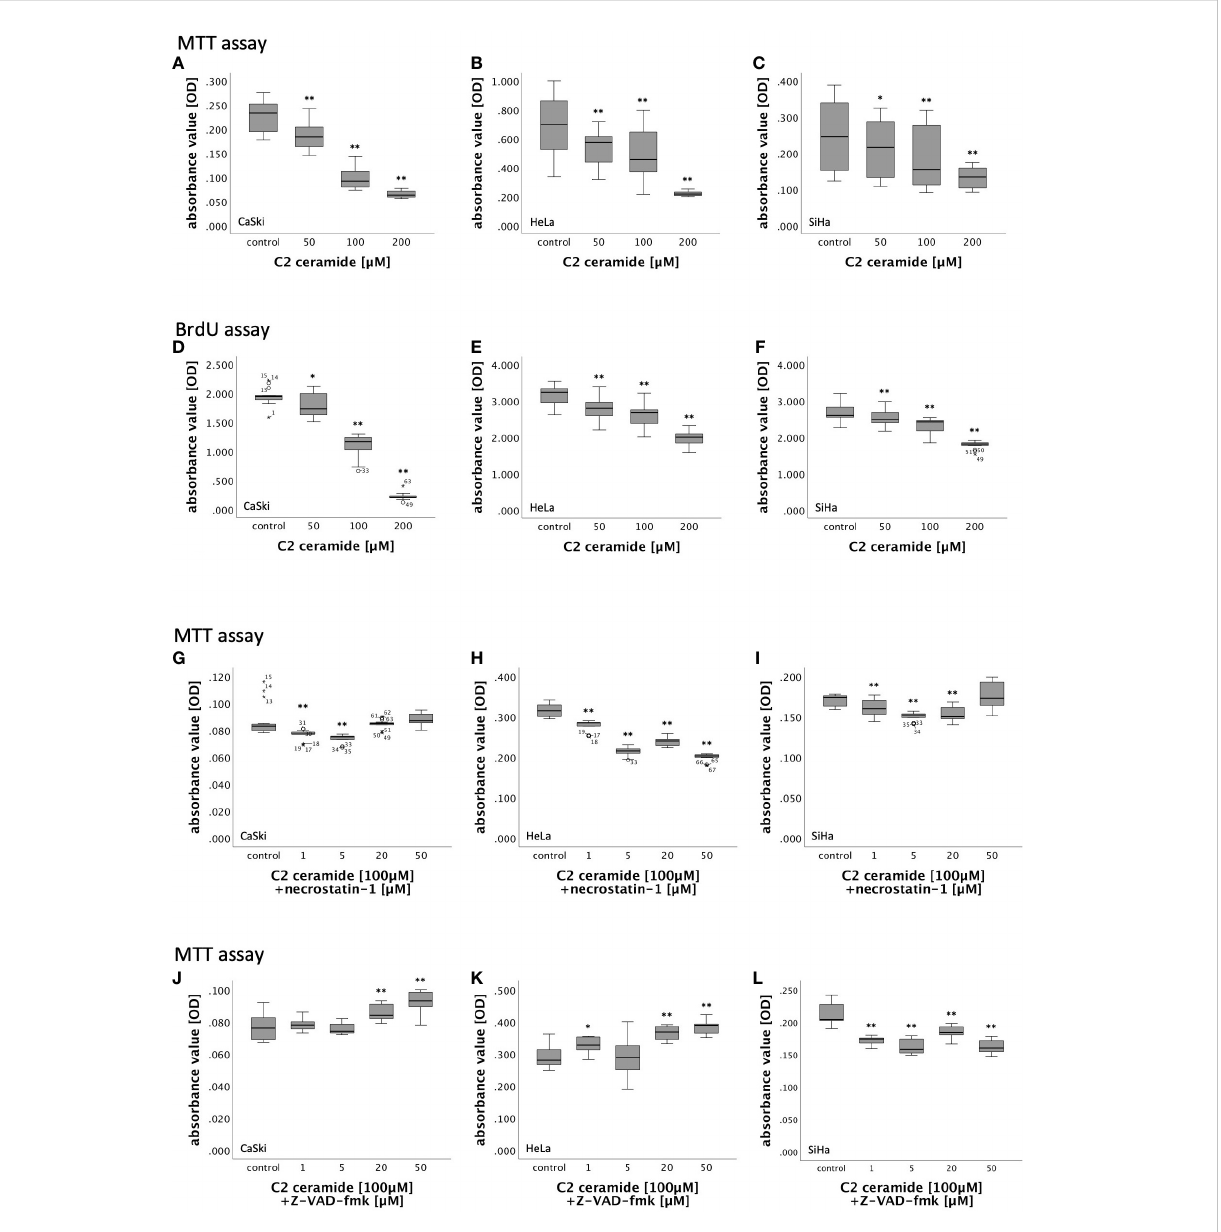
FIGURE 5 (A – F) MTT- and BrdU assay results of cervical cancer cell lines (CaSki, HeLa, SiHa) after 72h stimulation with C2 ceramide (50µM, 100µM, 200µM) compared to the respective DMSO control. (G – L) MTT assay results of cervical cancer cell lines (CaSki, HeLa, SiHa) after 48h stimulation with C2 ceramide (100µM) and necrostatin-1 (1µM, 5µM, 20µM and 50µM) compared to the respective DMSO control (G – I) and after 72h stimulation with C2 ceramide (100µM) and Z-VAD-fmk (1µM, 5µM, 20µM and 50µM) compared to the respective DMSO control (J – L) (for each concentration respectively control: n = 15, **p < 0.001, *p <